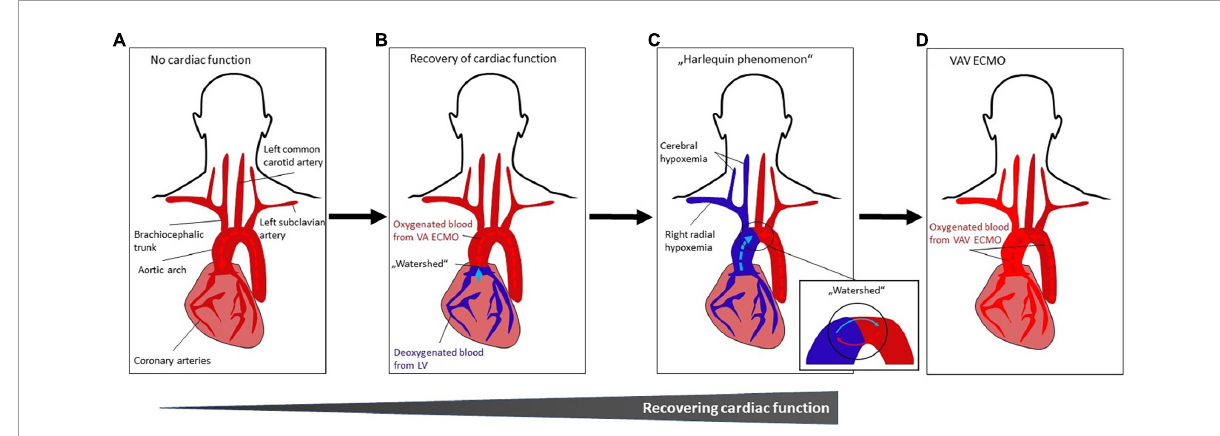
FIGURE4 (A–D) Occurrence and treatment of differential hypoxemia during VA ECMO treatment . (A) No cardiac function. Systemic perfusion with oxygenated blood (indicated by dark red color) is solely dependent from VA ECMO flow which is infused retrogradely toward the heart. (B) Recovery of cardiac function with impaired pulmonary gas exchange. The LV starts ejecting poorly oxygenated blood from the pulmonary circulation (indicated by blue color) that mixes with oxygenated blood from the VA ECMO (“watershed” or “mixing cloud”). The location of the “watershed” depends on the LV function and the VA ECMO flow. With severe myocardial dysfunction (e.g., due to cardiac arrest), the watershed is close to or at (if asystolic patient) the aortic valve. (C) Harlequin phenomenon. With improving LV function, the “watershed” may move more distally in the aortic arch. As a result, given impaired pulmonary function, poorly oxygenated blood from the LV is ejected into the aortic arch, coronary and cerebral arteries, resulting in ischemia and cyanosis of the upper body (in this case, right upper body), while the lower body is sufficiently oxygenated by the VA ECMO circuit. This phenomenon is known as differential hypoxemia , watershed phenomenon , two-circulation syndrome or Harlequin phenomenon . (D) VAV ECMO. The Harlequin phenomenon ( Figure 3C ) can be treated by converting VA ECMO to VAV ECMO. Thus, ECMO-oxygenated blood (indicated by lighter red color) is infused from a third ECMO cannula via the jugular or subclavian vein through and the pulmonary circulation into the LV and upper body (see Figure 1C ). Abbreviations: left ventricle (LV); veno-arterial extracorporeal membrane oxygenation (VA ECMO); veno-arterio-venous ECMO (VAV